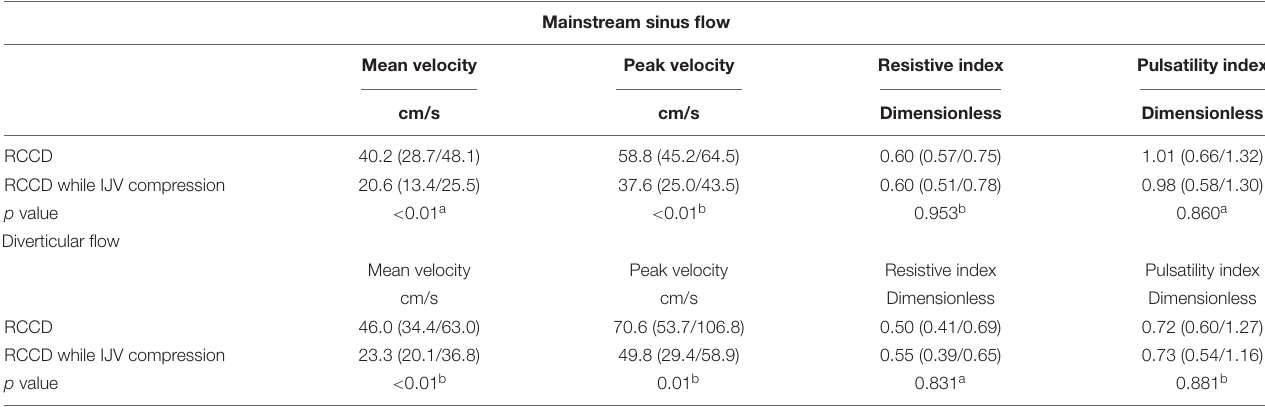
TABLE 2 | Results of RCCD transverse–sigmoid junction hemodynamics of 19